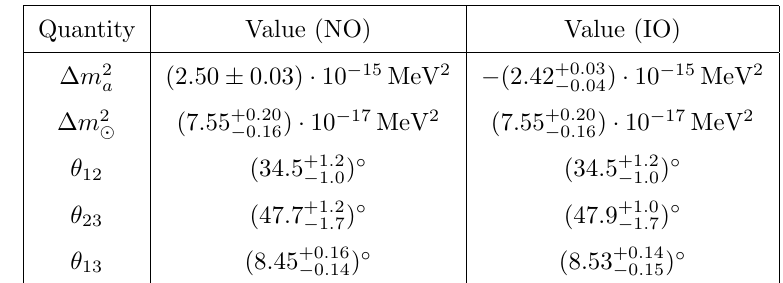
= m 2 (cid:0) m 2 and a 3 1